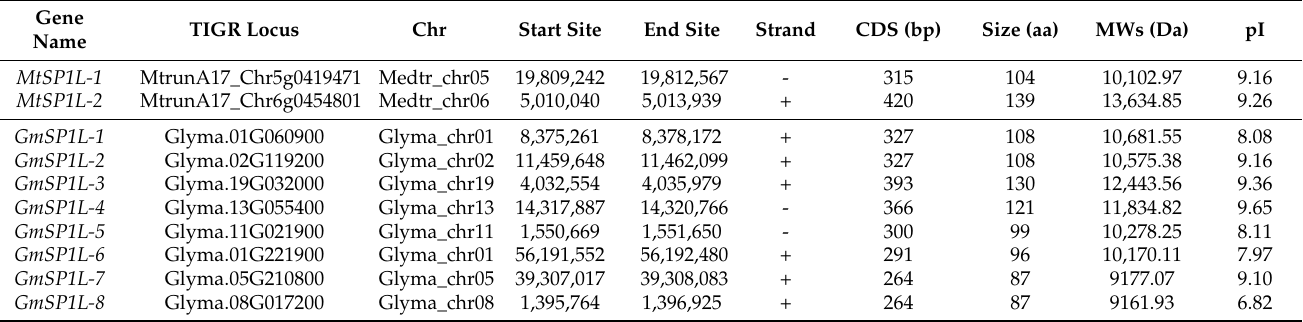
Table 1. Properties of the predicted SP1L genes in M. truncatula and G. max